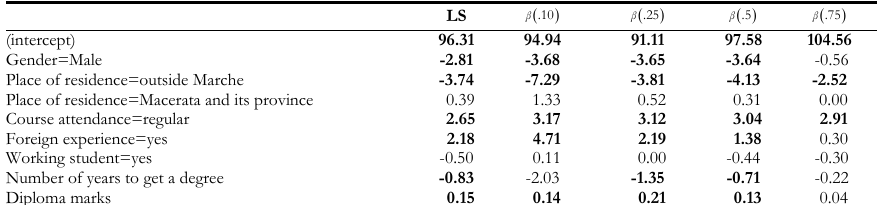
LS and quantile regression coefficients (in bold significant coefficients at α =0.10)